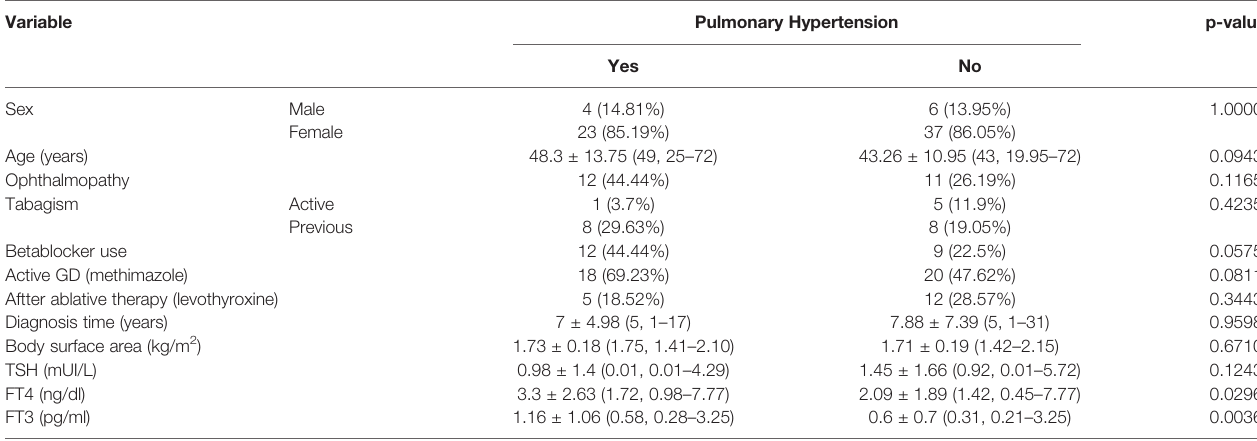
TSH, thyroid-stimulating hormone; FT4, free thyroxine; FT3, free tri-iodothyronine. Categoricalvariablesarerepresentedbytheabsolutevalueandfrequencyinpercentage.Continuousvariablesarerepresentedbyvaluesofmean±standarddeviation(median,minimum, and